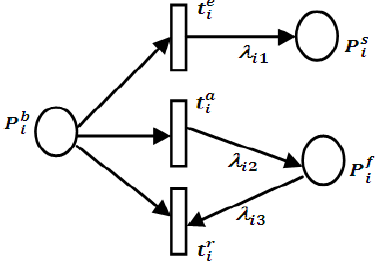
Figure 1. Security component model based on SPN.